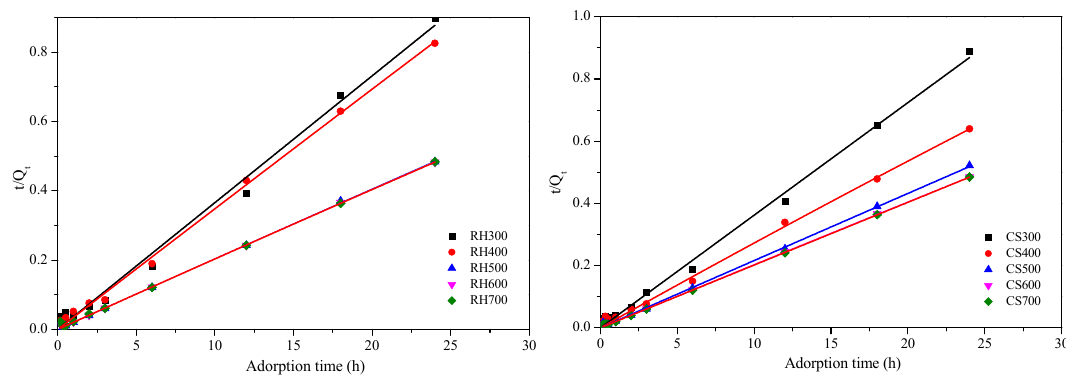
Figure 6. First-order kinetics analysis for Cd 2+ adsorption by both sets of biochar samples. Notes: RH300, RH400, RE500, RH600, and RH700 indicate that rice husk were pyrolyzed at 300, 400, 500, 600 and 700 °C, respectively; CS300, CS400, CS500, CS600, and CS700 indicate that cotton straw were pyrolyzed at 300, 400, 500, 600 and 700 °C, respectively.